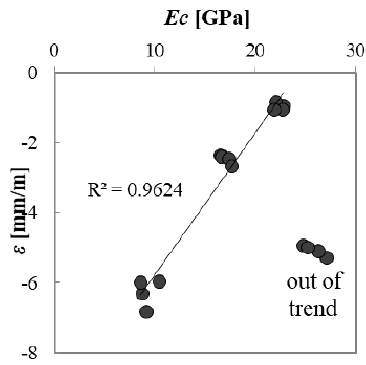
Figure 6. Correlation between drying shrinkage at 40 days and modulus of elasticity.